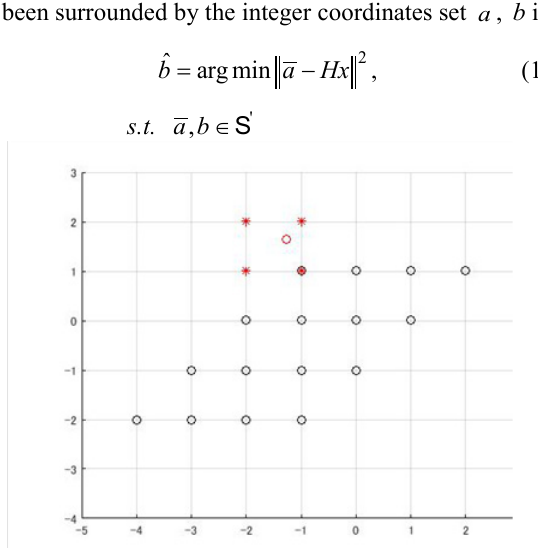
Fig. 7. Flowchart of proposed